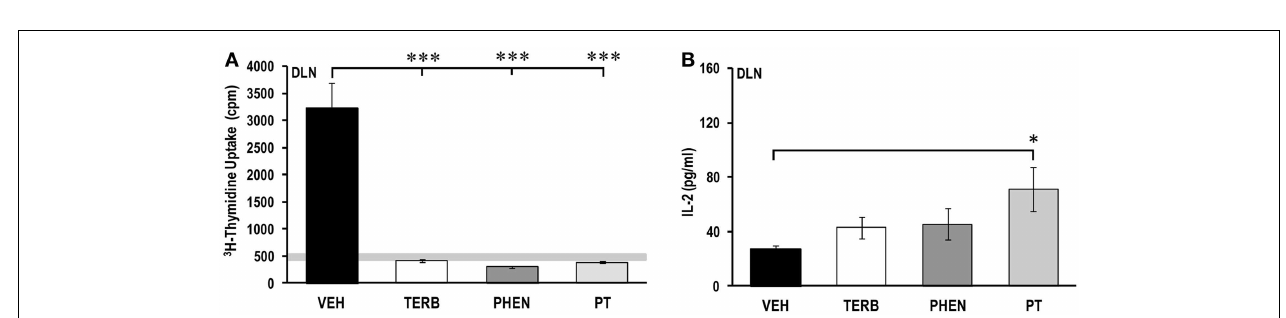
FIGURE 5 | Cytokine production by spleen (SPL) cells after 24h of culture . Animals were treated with twice-daily i.p. injections of vehicle (VEH, black bars), terbutaline (TERB, white bars), phentolamine (PHEN, dark gray bars), or phentolamine and